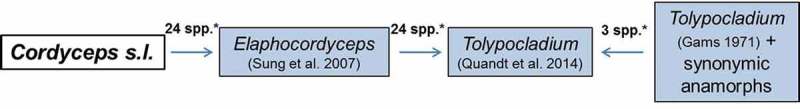
Species composition of Tolypocladium. * indicates the no. of spp. transferred from one genus to another.